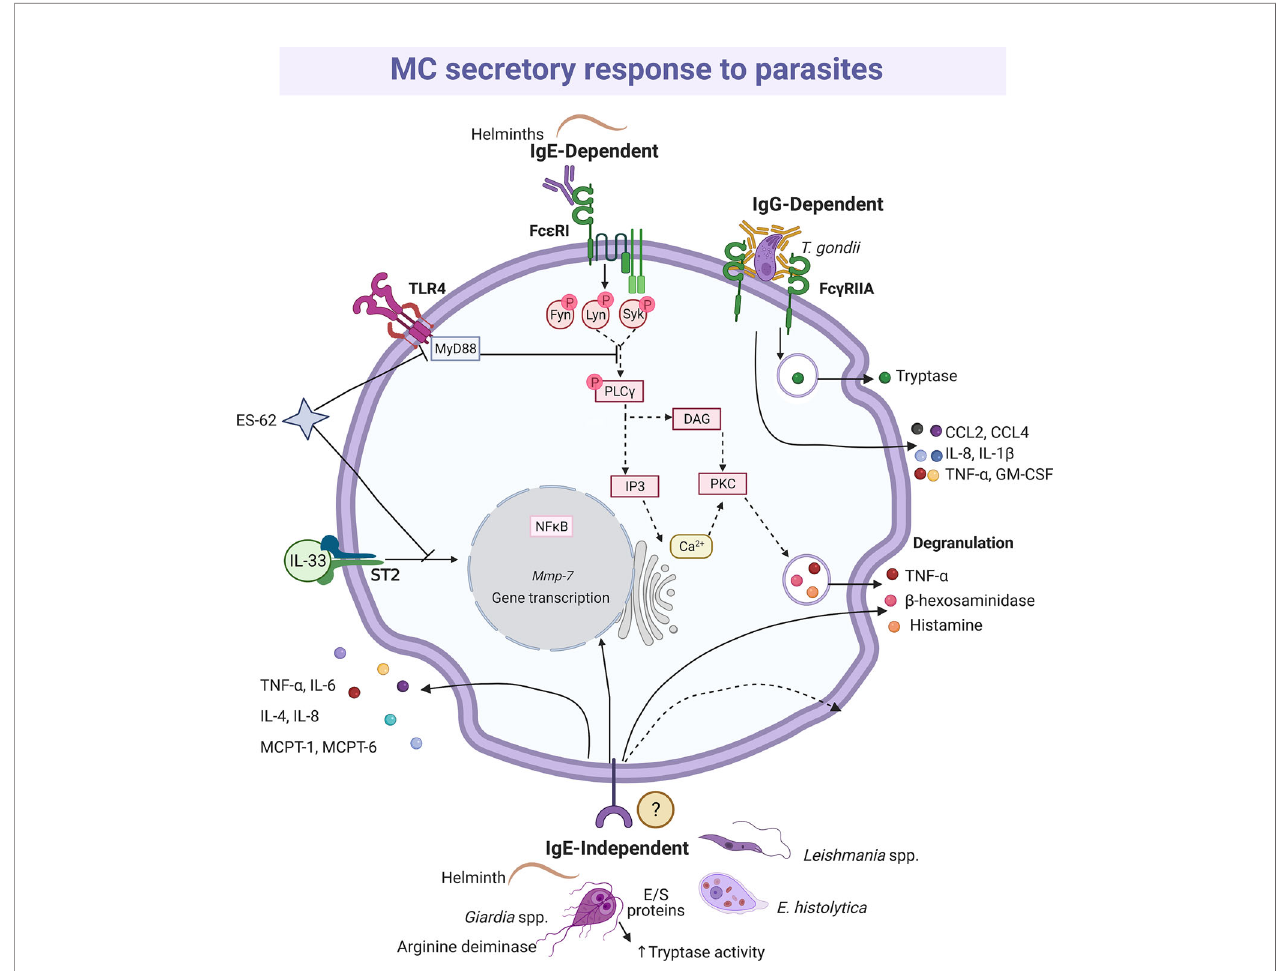
FIGURE 6 | MC-released mediators and signaling pathways elicited by parasites. Distinct parasites promote IgE-dependent and IgE-independent activation patterns. When recognized by IgE, helminths induce full degranulation and cytokine secretion as it has been described for IgE/antigen complexes and the shown intracellular signaling cascade is inferred. Antigen-dependent crosslinking of the IgE molecules bound to Fc ϵ RI monomers causes the activation and autophosphorylation of two Src family kinases, named Lyn and Fyn. In turn, those kinases phosphorylate the immunotyrosine-activation-motifs located in the g and b subunits of the receptor, creating docking sites for the amplifying kinase Syk. Once recruited and activated, Syk phosphorylates membrane adapters that will conform two main protein complexes directing the signaling i) to the main events leading to calcium mobilization and degranulation, and ii) to secondary processes that contribute to sustain degranulation and induce migration and cytokine production. In order to trigger degranulation, the activated phospholipase C (PLC) g hydrolyses phosphatidylinositol 4,5-bisphosphate to produce diacylglycerol (DAG) and inositol 3-phosphate (IP3). Those messengers activate several isoforms of protein kinase C (PKC) and the IP3 receptor located in endoplasmic reticulum intracellular Ca 2+ storages. The main fi nal consequences of this signaling branch are the release of Ca 2+ to the cytoplasm and the phosphorylation of distinct proteins involved in the fusion of granules to the plasma membrane. Crosslinking of Fc g RIIA receptors by bound-cell IgGs results in a polarized and sustained release of the granule content at the contact surface between both cells, named antibody- dependent degranulatory synapse (ADDS). ES-62 protein inhibits interleukin (IL)-33-dependent ST2 receptor activation and targets MyD88, which causes downregulation of cytokine synthesis triggered by TLR4 and Fc ϵ RI receptors, while excretion/secretion (E/S) proteins from Giardia increase tryptase activity. IgE- independent activation is mediated by not well-de fi ned receptors and causes histamine and cytokine secretion. In this fi gure, solid-lines indicate reported effects of receptor triggering or MC-parasite interactions, whereas dashed-lines show suggested activated pathways, assuming the activation of the high af fi nity IgE receptor (Fc ϵ RI) in this cell